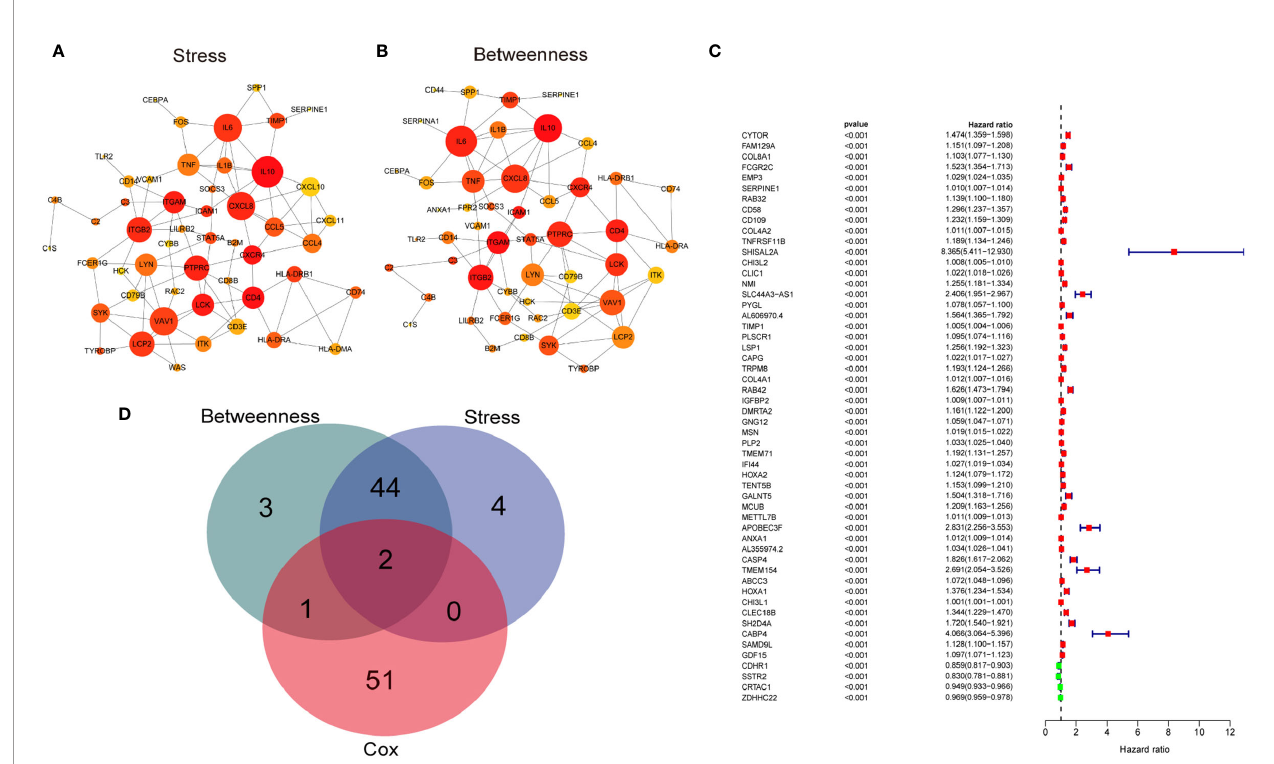
FIGURE 3 | Screening target genes. (A) The network of top 50 hub genes screened by CytoHubba Stress algorithm. (B) The network of top 50 hub genes screened by CytoHubba Betweenness algorithm. Node size indicated its connectivity (the larger the node, the more proteins interacted). Node color indicated gene ranking (top-ranked genes colored by relatively darker color). (C) Forest plot showing hazard ratios with p ‐ values and 95% CI measured by univariate Cox regression analysis. The dashed line marked hazard ratio=1. Red boxes represented unfavorable prognosis genes, and blue boxes remarked favorable prognosis genes. CI, con fi dence interval. (D) Venn plots showing the intersected genes between hub genes and survival-related